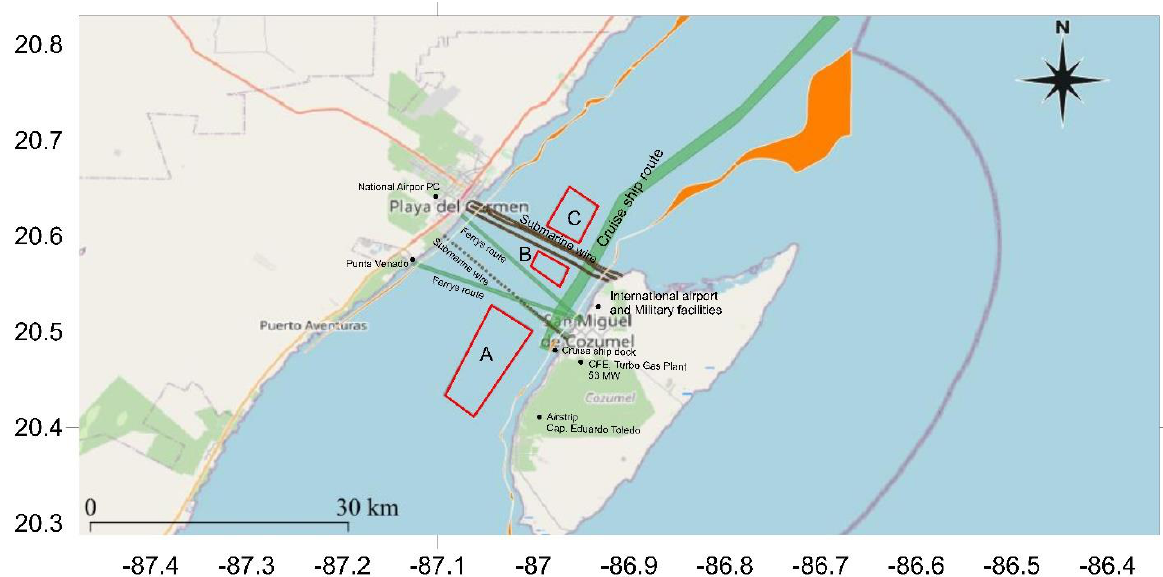
Figure 11. Maritime traffic and submarine cables that could restrict the use of marine currents. Sites A, B, and C have the fewest restrictions of an environmental or social nature. Sources: (Secretary of the Navy, 2010), (Conabio, 2020), (Open-Sea-Map, 2020).